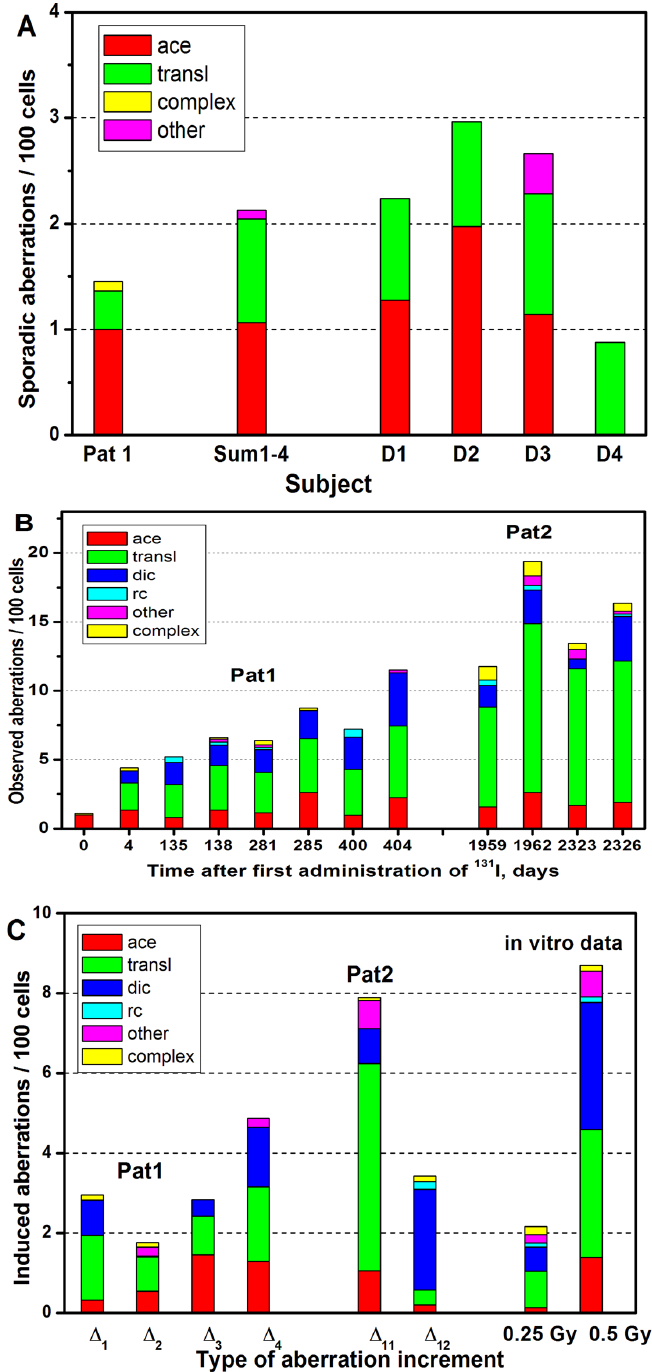
Figure 1. ( A ) The aggregate control frequency and spectrum of different types of chromosomal aberrations detected by mFISH in Patient 1 before RIT (day 0, 1102 cells) and in non-irradiated blood samples of four healthy donors: the sum for all four donors (Sum 1–4, 1223 cells) and separately (D1, D2, D3, D4); ( B ) the frequency and spectrum of different types of observed chromosome aberrations detected by mFISH as a result of 1–4 courses of RIT (Patient 1) and 11–12 courses of RIT (Patient 2); ( C ) the frequency and spectrum of different types of induced chromosomal aberrations in terms of increase, ∆, detected by the mFISH, as a result of 1–4 courses of RIT (Patient 1: ∆ 1 – ∆ 4 ) and 11–12 courses of RIT (Patient 2: ∆ 11 – ∆ 12 ). For comparison, the increases of induced aberrations (i.e., observed level minus control) are shown, amounting to four donors at 0.25 Gy (1003 cells) and 0.5 Gy (693 cells) obtained by in vitro γ -exposure of blood